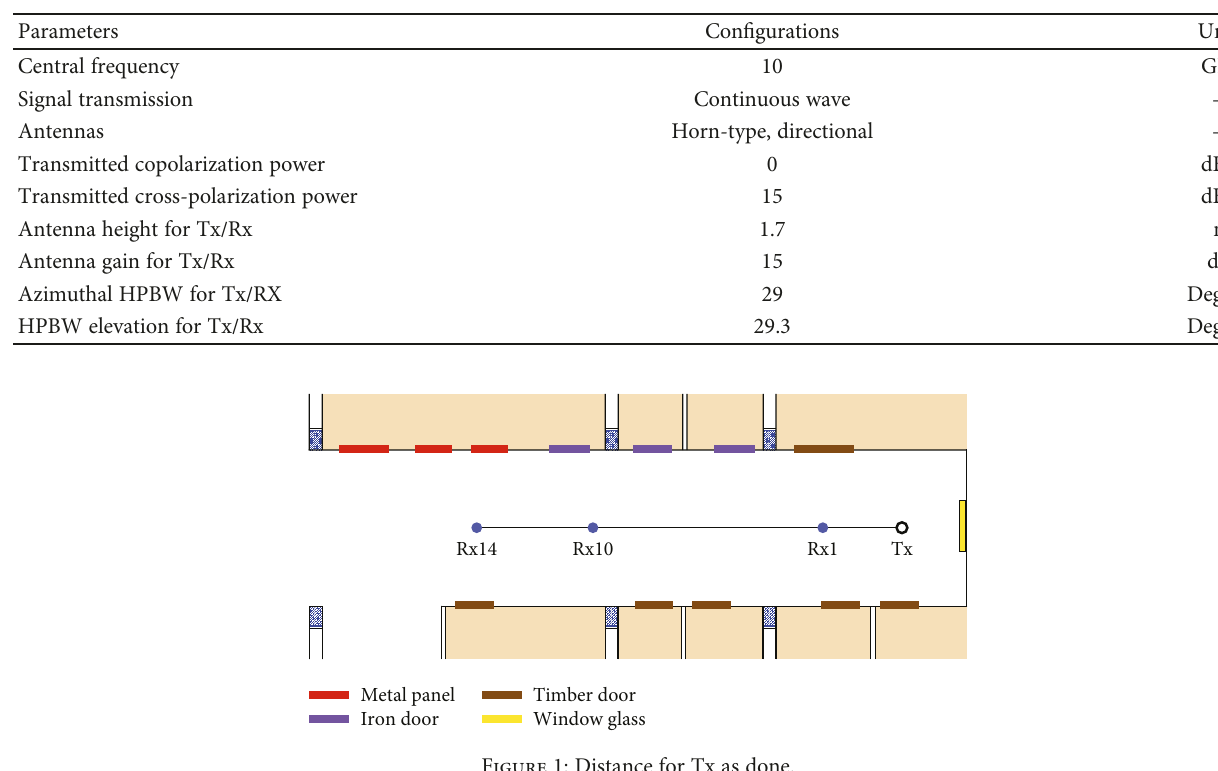
Table 1: Channel sounding system speci fi cations for the 10GHz indoor measurement campaign.